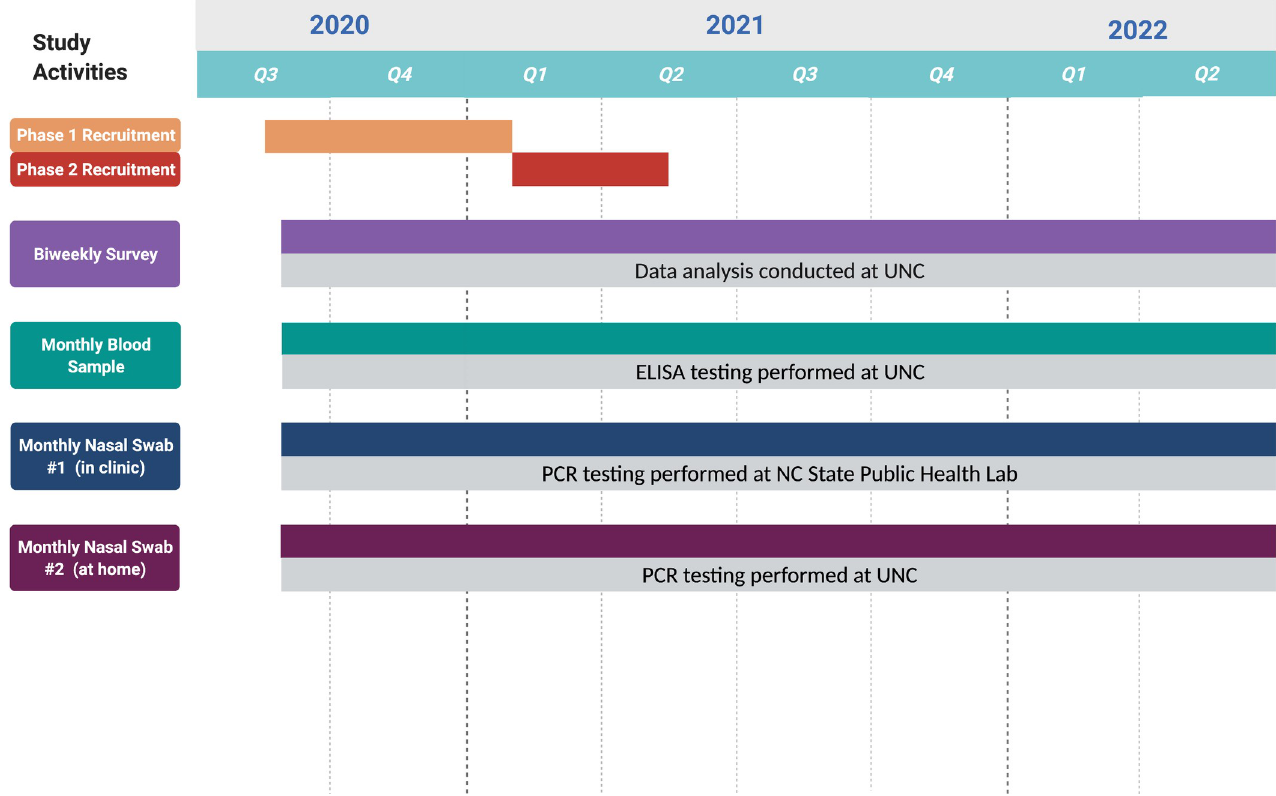
PLOS ONE | https://doi.org/10.1371/journal.pone.0259070 October 25,